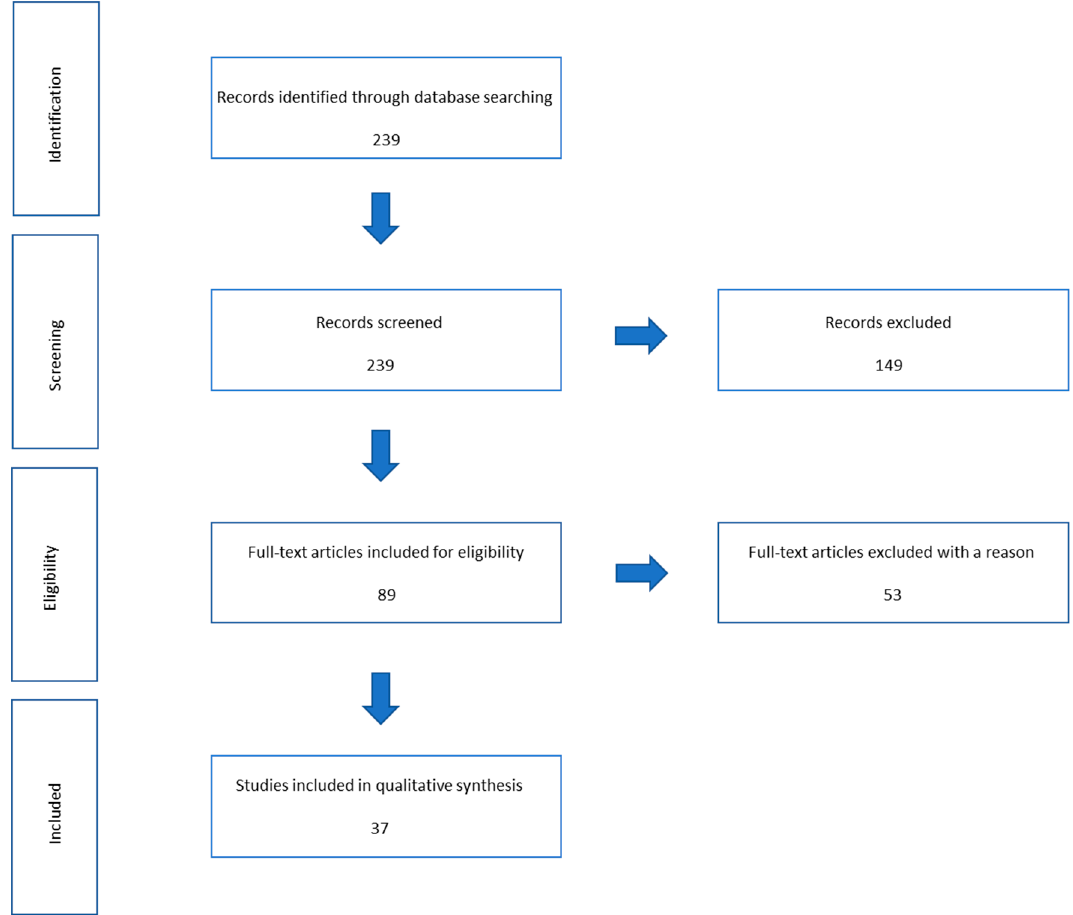
Figure 2. Flowchart of included and excluded studies.